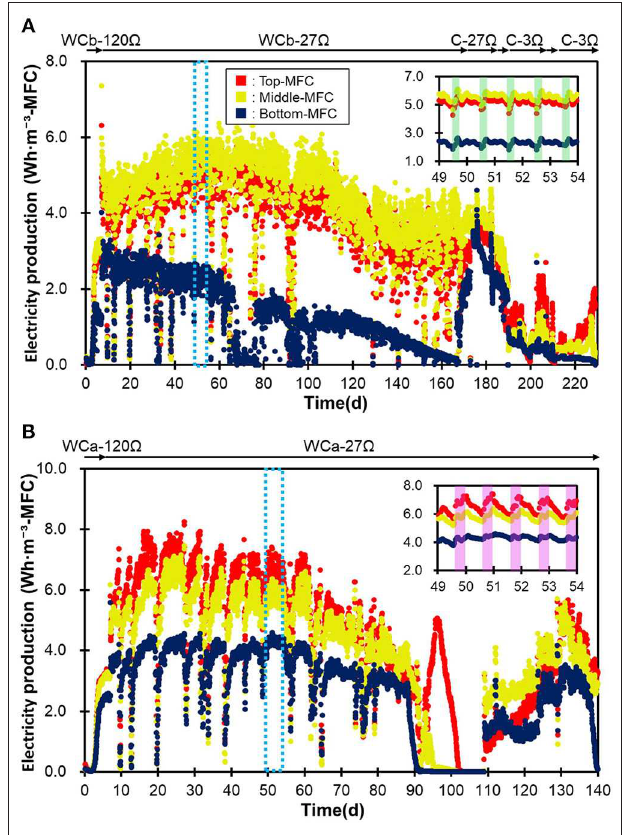
FIGURE 2 | The production of electricity by the three MFCs in the IN-MFC module (A) and EF-MFC module (B) . WCb and WCa show the MFCs that were operated in the water channel before and after treatment in the PST, respectively. C indicates the MFCs in a chemostat reactor polarized via resistances of 3 (C-3 (cid:127) ) and 27 (cid:127) (C-27 (cid:127) ). The green frame represents the morning (5:30–11:30) while the purple frame represents the